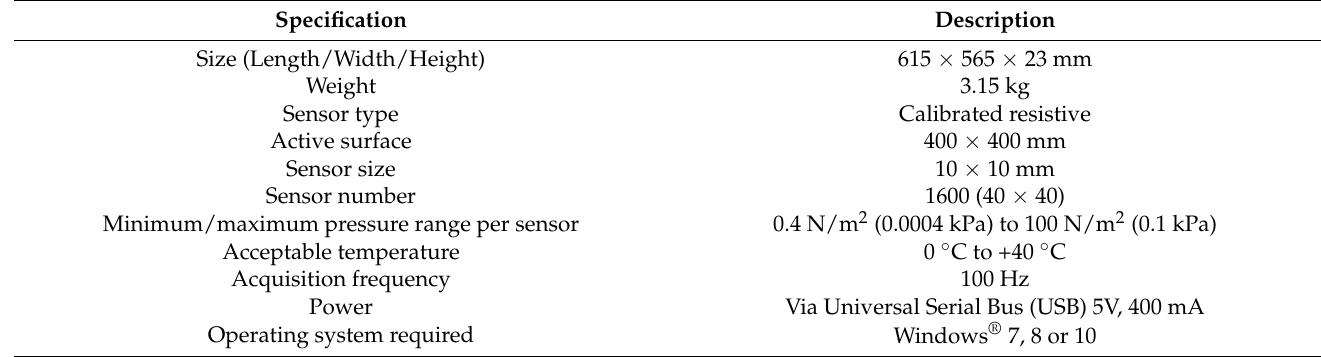
Table 1. Technical specifications of the pressure